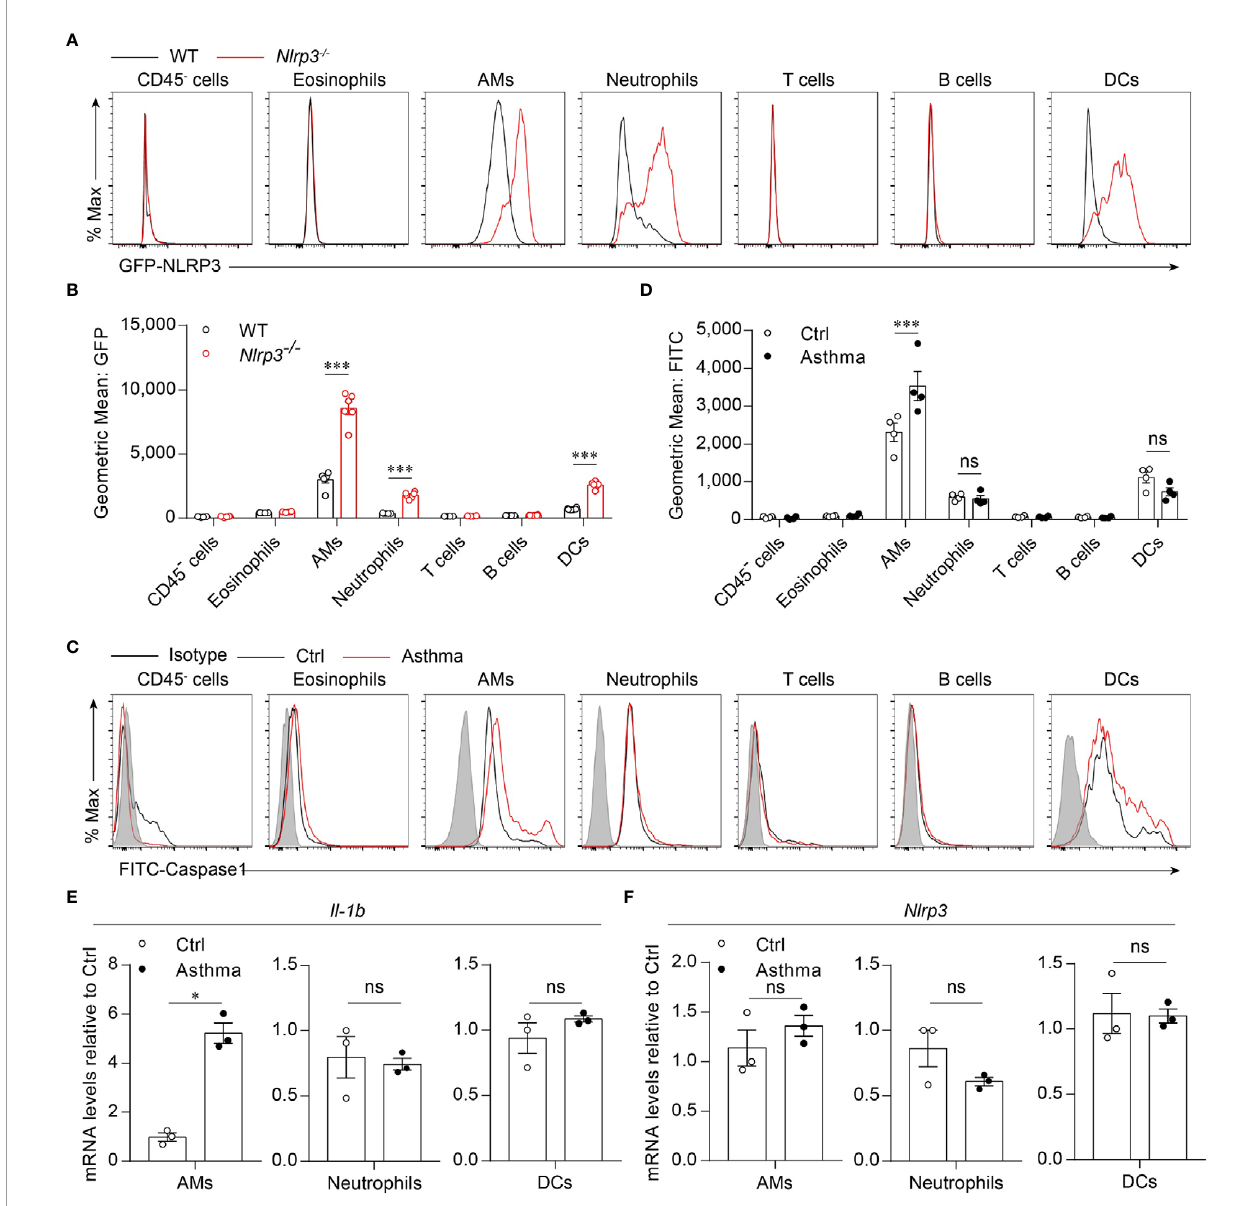
FIGURE 2 | HDM induces NLRP3 in fl ammasome activation in alveolar macrophages. (A, B) Flow cytometry analysis of the GFP fl uorescence intensity in the cells from the lung of WT and Nlrp3 -/- mice induced allergic asthma with HDM. The histograms (A) and the geometric mean fl uorescence intensities (Geo MFIs) (B) of GFP; n = 6 biologically independent mice. (C, D) Flow cytometry analysis (C) and quanti fi cation (D) of cleaved caspase-1 activation in lung cells; n = 4 biologically independent mice. (E, F) IL-1 b (E) and Nlrp3 (F) mRNA levels in AMs, neutrophils and DCs sorted from control and asthmatic mice lungs; n = 3 biologically independent mice. Statistical signi fi cances were analyzed by unpaired Student ’ s t -test: * P < 0.05, *** P < 0.001, ns (not signi fi